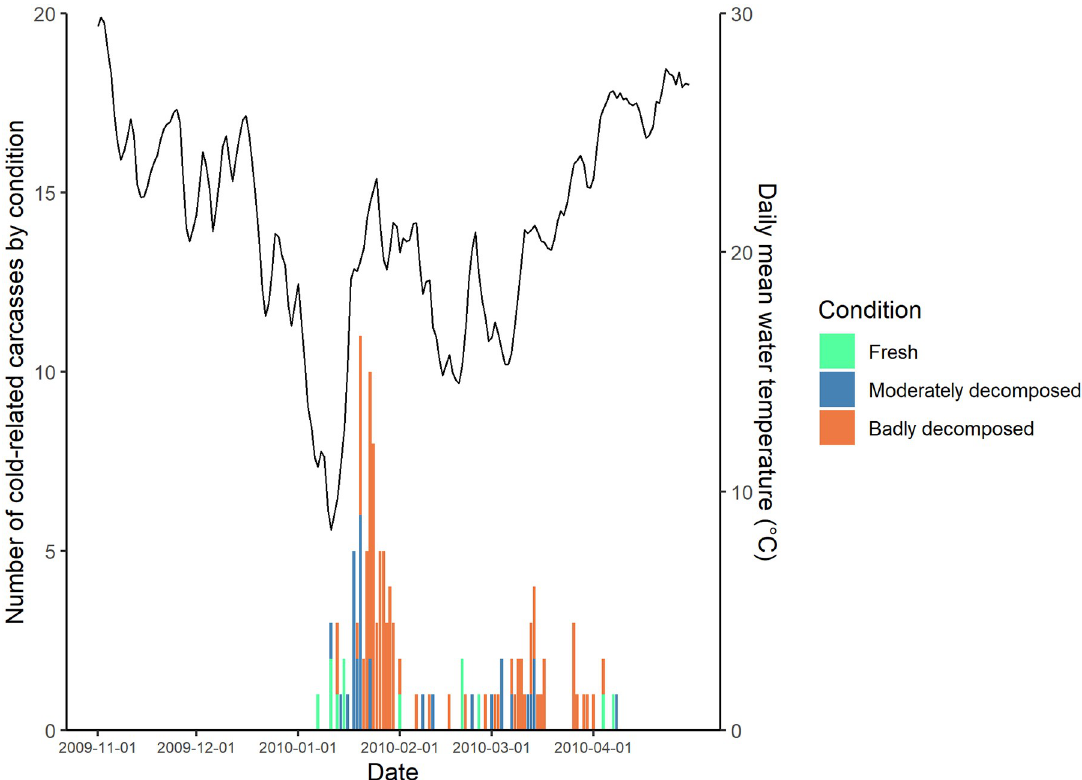
Fig 7. Number of cold-related manatee carcasses reported by day and condition code in the central-east (CE) region during winter 2009–2010. Mean daily water temperature from the water monitoring site in Indian River at Vero Beach (see Fig 1) is plotted in black. Note that the scales on the y-axis for carcass counts differ between Figs 7 and